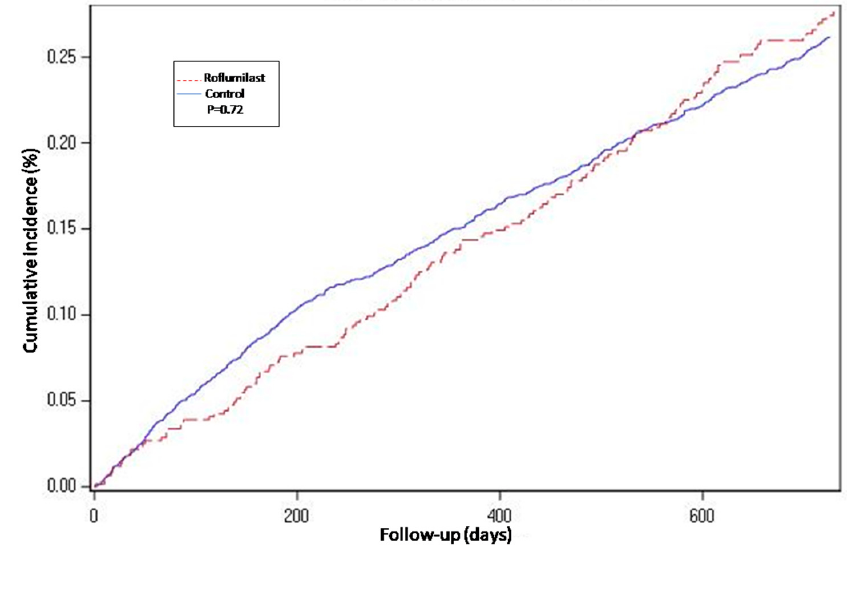
Figure 3 . Hospital-requiring acute COPD exacerbation . Cumulative incidence for the three compared groups. ( a ) Propensity-matched population (Roflumilast vs. Control): Unadjusted Cox proportional hazard model (matched on FEV1, MRC, age, gender, smoke status, number of AECOPD-Hosp 1 year prior to baseline, ICS prescription and LAMA/LABA prescription). ( b ) Roflumilast versus Theophylline: unadjusted Cox proportional hazard mode (Propensity score matched on FEV1, MRC, age, gender, smoke status, number of AECOPD-Hosp 1 year prior to baseline, ICS prescription, LAMA/LABA prescription and calendar year). ( c ) Unmatched population (Roflumilast vs. Control): adjusted Cox proportional hazard model (adjusted for FEV1, MRC, age, gender, smoke status, number of AECOPD-Hosp 1 year prior to baseline, ICS prescription and LAMA/LABA prescription). Follow-up period of two years.